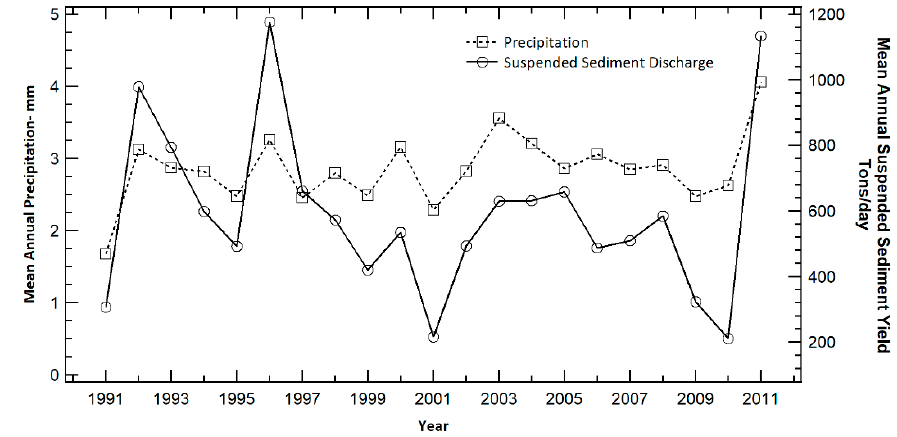
Figure 7. Variation in suspended sediment yield and precipitation.